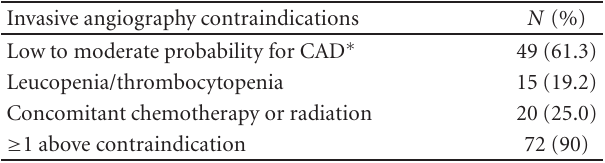
Table 1: Baseline cardiac CT angiogram population characteristics. Population characteristics